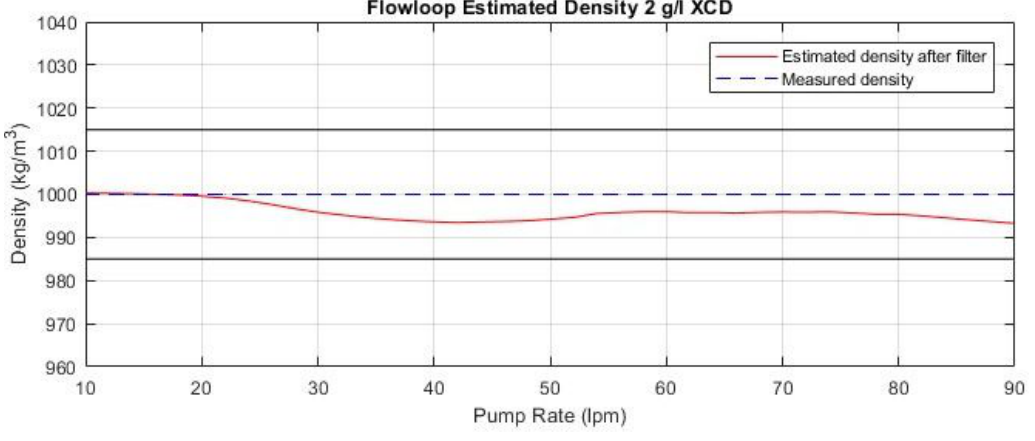
Figure 2: Estimated density of Formulation 1